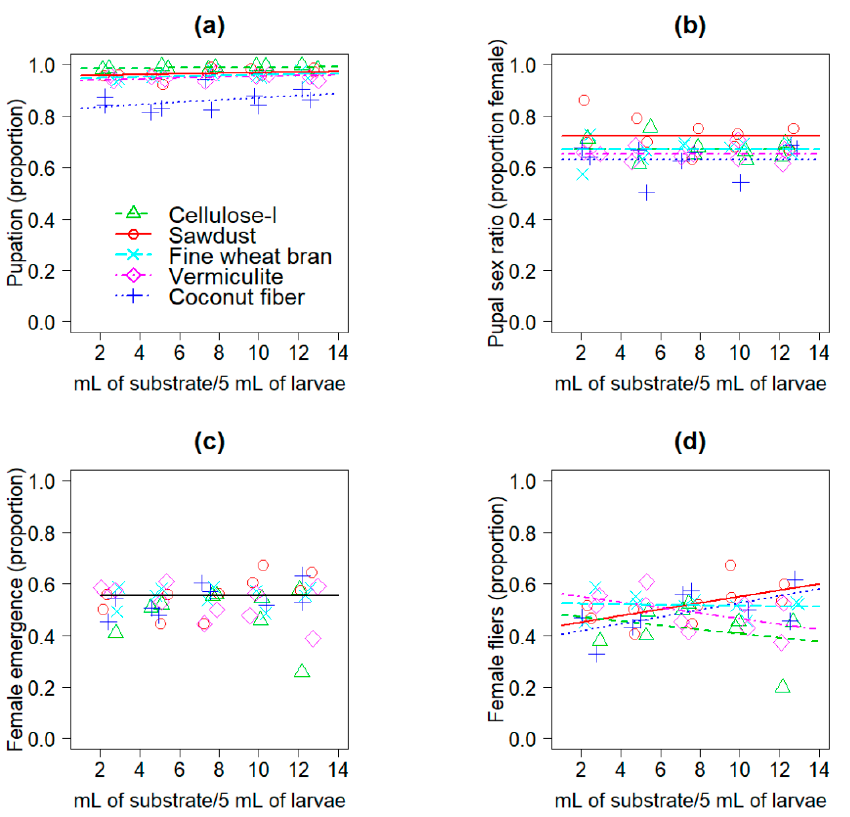
Figure 1. Models fitted to data on ( a ) pupation, ( b ) pupal sex ratio, ( c ) female emergence and ( d ) female fliers of C. capitata VIENNA 8 GSS as a function of the type of pupation substrate and substrate volume with a fixed volume of larvae (5 mL). Lines represent the models and symbols jittered data points; in ( c ) the horizontal black line represents the null model.